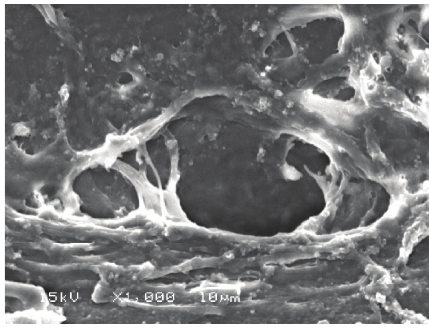
Figure 6: SEM of SLT-treated tissue (2.0 mJ). Note the destruction of trabecular beams with tissue scrolling at the edges of the treated